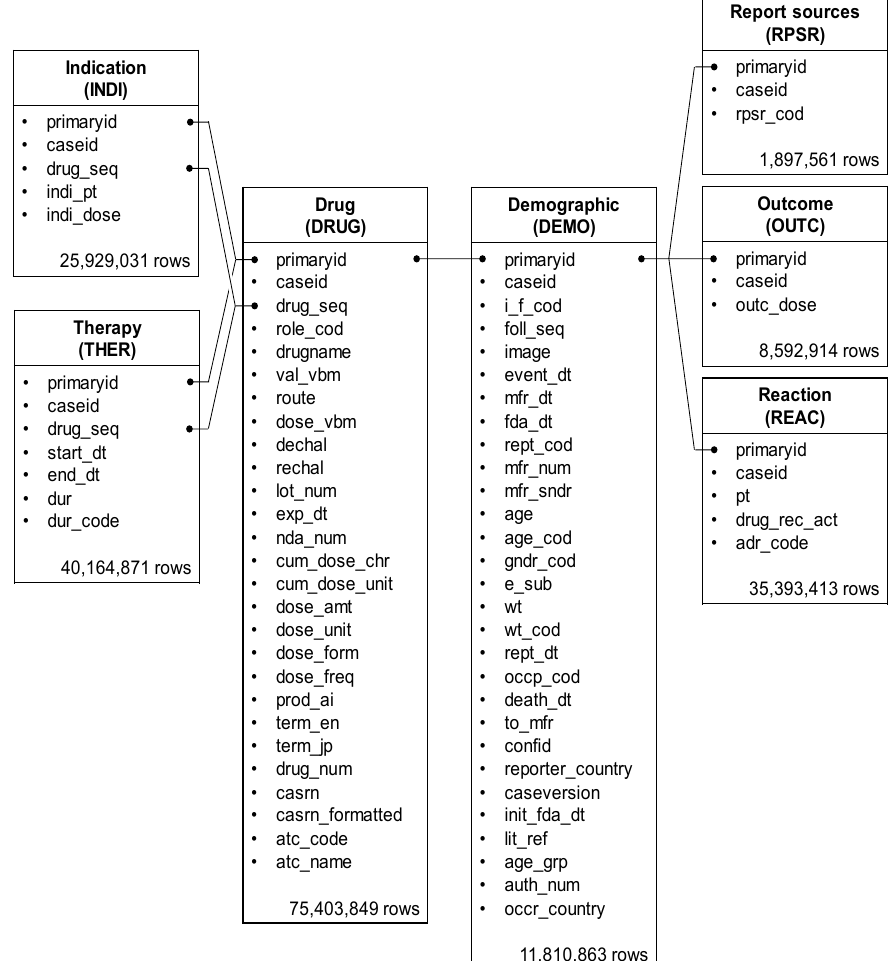
Figure 6. Seven information tables included in the FAERS database. The row number shows the number of reports obtained between April 2004 and September